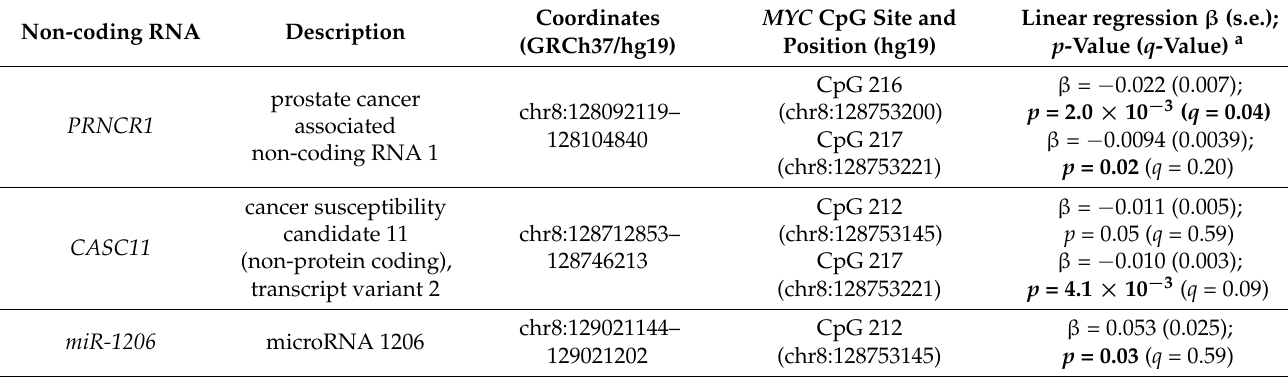
Table 5. Top hits for MYC DNA methylation and RNA expression in prostate tumor tissue ( p ≤ 0.05), n = 89 tumor tissue samples from the University of Maryland. Non-coding